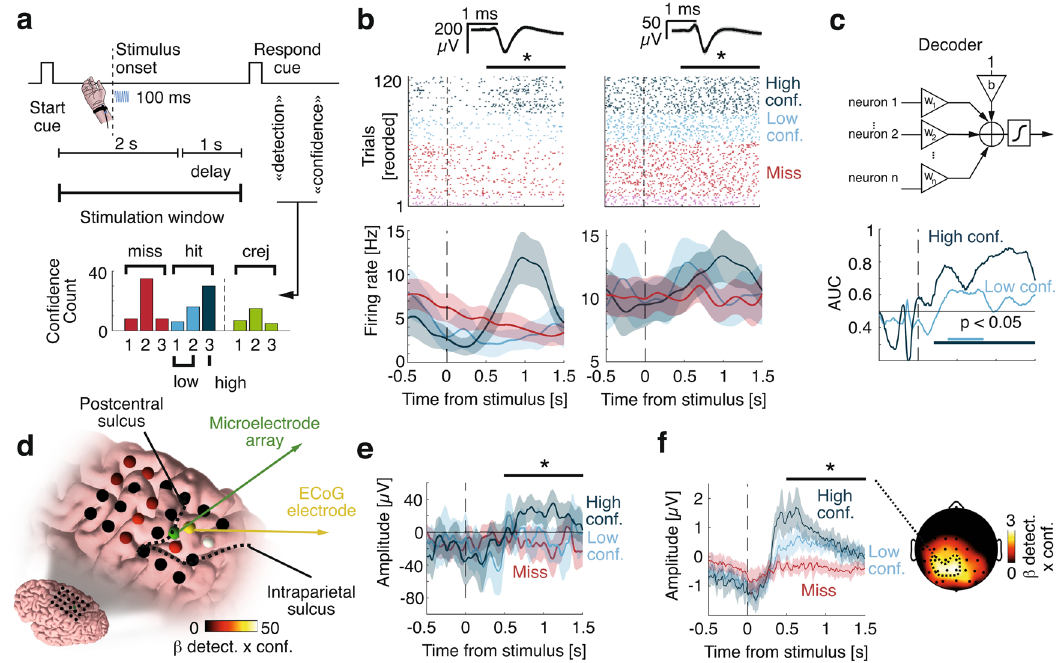
Fig. 2 Neuronal correlates of detection and con fi dence in a delayed-response task (Experiment 2). a Top: Vibrotactile stimuli were applied during a 2 s window following an auditory cue. After a 1 s delay, the participant was prompted to give detection and con fi dence reports. Bottom: Distribution of con fi dence. For display purposes hereafter, signals corresponding to con fi dence values of 1 and 2 were merged into low con fi dence, while con fi dence values of 3 were considered as high-con fi dence. Statistics were done on the three levels. b Example selective neurons. Top: Raster plot time-locked to stimulus onset with spike waveform with shaded standard deviation above. Bottom: Corresponding fi ring rates. Asterisks indicate statistical signi fi cance; Left: p < 0.001 (Generalized linear model with Gamma link); Right: p = 0.036. c Top: schematic representation of a decoder based on weighted averages of neuronal fi ring rates. Bottom: Corresponding decoding performance for different con fi dence levels. Horizontal lines show times of signi fi cant performance ( p < 0.05, one-sided permutation tests to correct for multiple comparisons). d ECoG grid with beta coef fi cients for detection x con fi dence. Non-signi fi cant electrodes are in black. e Average ECoG amplitudes, aligned to stimulus onset from the electrode next to the microelectrode array. Asterisks indicate statistical signi fi cance ( p < 0.001; linear model). f The EEG amplitude time-locked to stimulus onset and averaged over 18 healthy controls for a cluster of signi fi cant electrodes depicted (dashed contour) on the topographic map on the right. The colormap corresponds to the beta coef fi cient for the interaction effect between detection and con fi dence. Asterisks indicate statistical signi fi cance ( p < 0.001; linear mixed model). In all panels, misses are depicted in red, hits in blue, correct rejections in green, shaded areas represent 95% CI, black horizontal bars represent the analysis window for statistics.